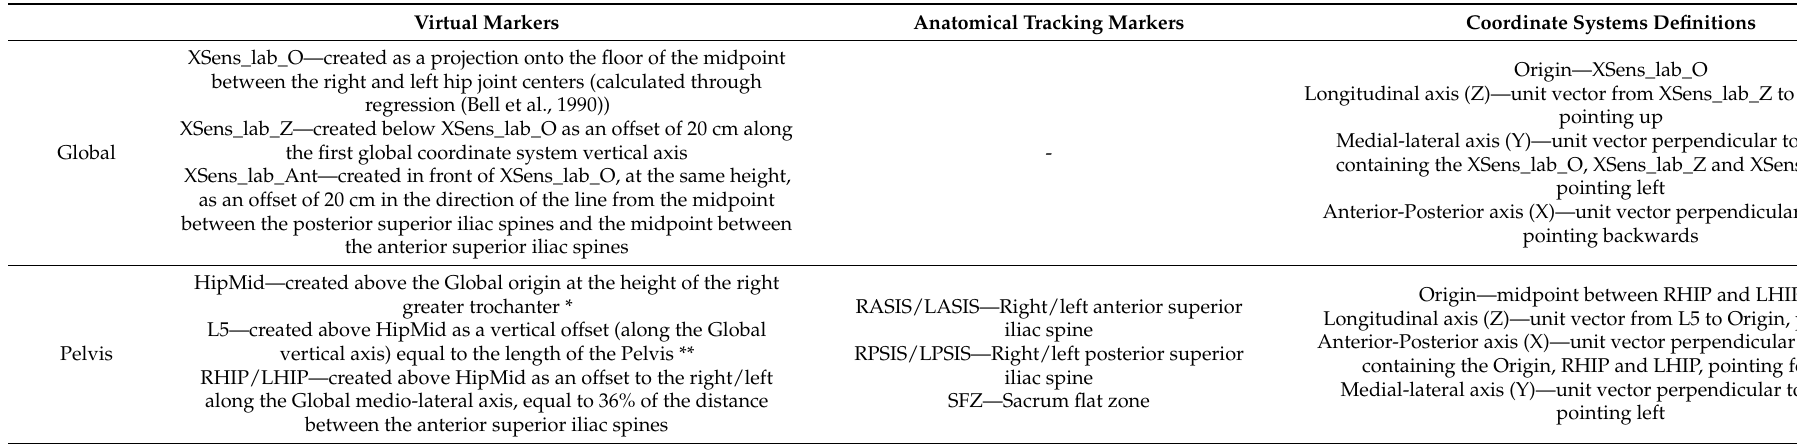
Table A1. Biomechanical model for OS: virtual markers, tracking markers, including rigid, lightweight plates/clusters and coordinate systems definitions. Measurements marked with * refer to the anthropometric measurements taken from the participant during the session. Measurements marked with ** are estimated through regression equations